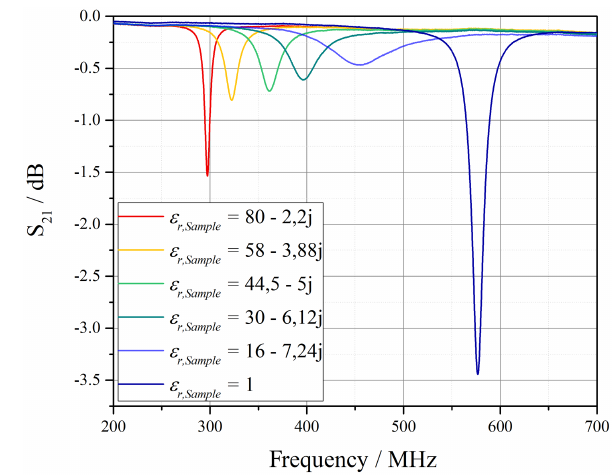
Figure 8. Validation of theory via measurements of water- isopropanol